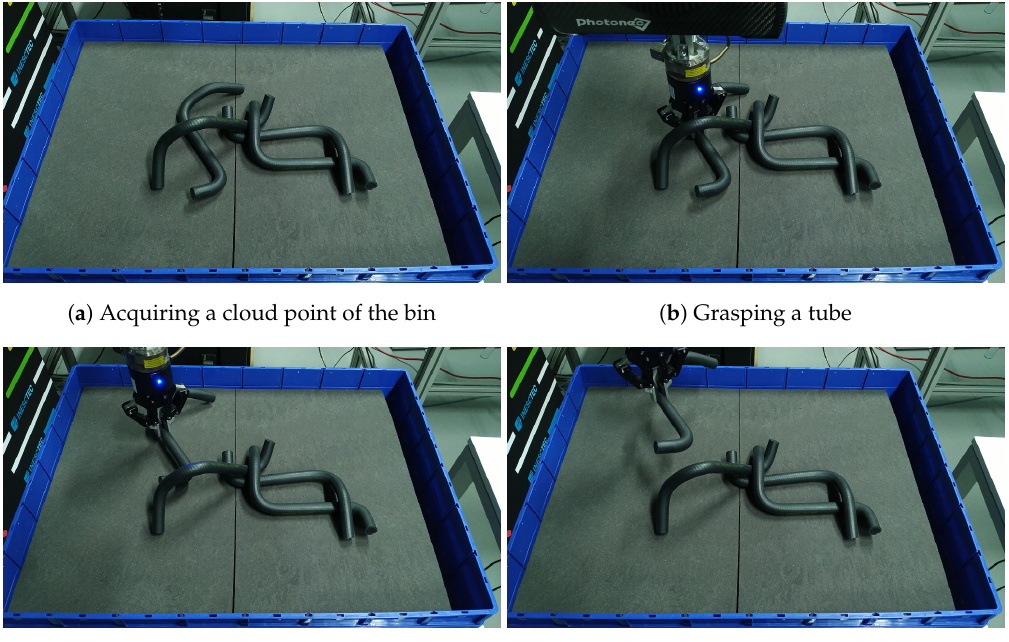
Figure 11. Successful escape trajectory example.